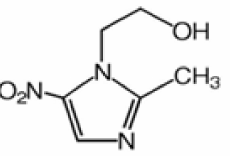
Figure 1. Chemical structure of metronidazole (MTZ)